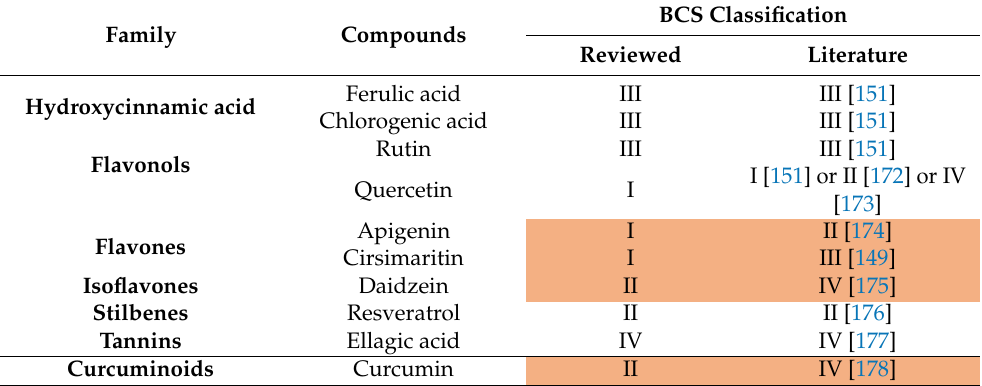
Table 3. Biopharmaceutical classification system (BCS) classification of phenolic compounds (PCs) based on the solubility and permeability criteria evaluated in this review and based on the current literature. Family